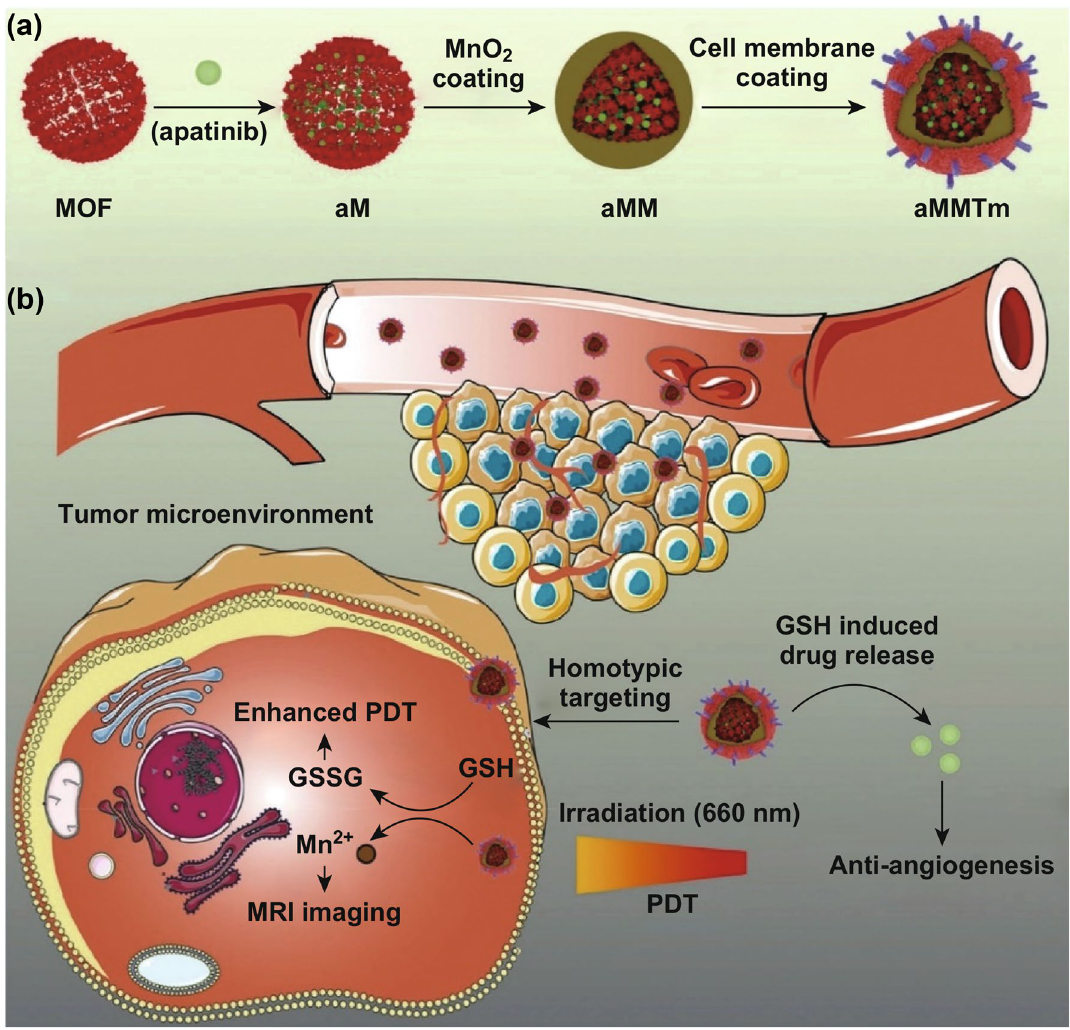
Fig. 3 a Porphyrin metal–organic framework nanoparticle aMMTm was constructed by drug loading, MnO 2 coating and tumor cell membrane decoration. b The proposed mechanism of action of aMMTm in mouse tumor model. Tumor cell membrane camouflage can help the early removal of nanoparticles and target tumor through homotypic affinity. At tumor site, MnO 2 shell reacts with GSH in the microenvironment or tumor cells, consuming excess GSH and enhancing the action of PDT. Simultaneously produced Mn 2+ can be used as MRI contrast agent. When MnO 2 shell degrades, the released apatinib neutralizes PDT-induced revascularization and prevents tumor progression. Adapted with permission from Ref. [22]. Copyright 2019